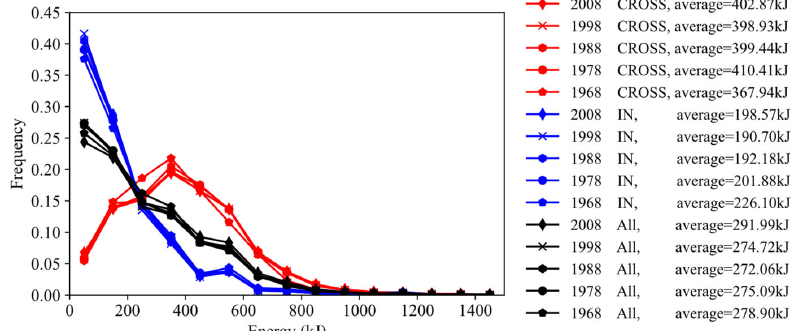
Figure 16. Energy expenditure for one trip (bin width = 100 kJ).